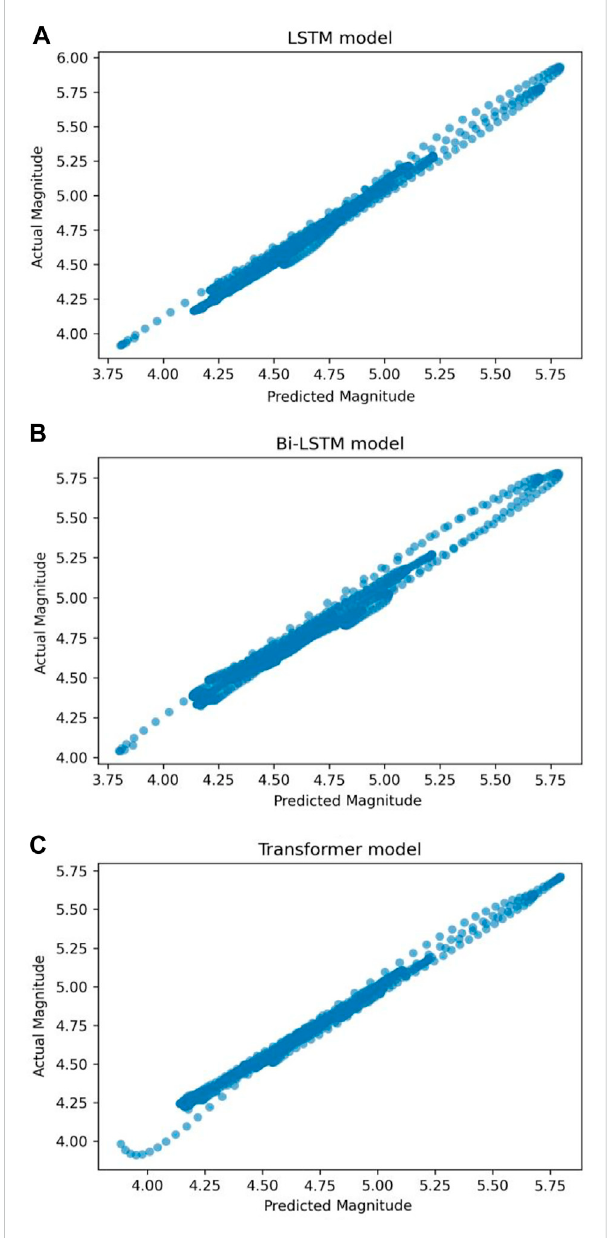
FIGURE 12 Error distribution of the (A) LSTM, (B) Bi-LSTM, and (C) transformer models applied to the Indonesia earthquake